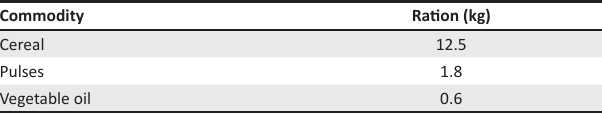
TABLE 3: Monthly ration of the feeding